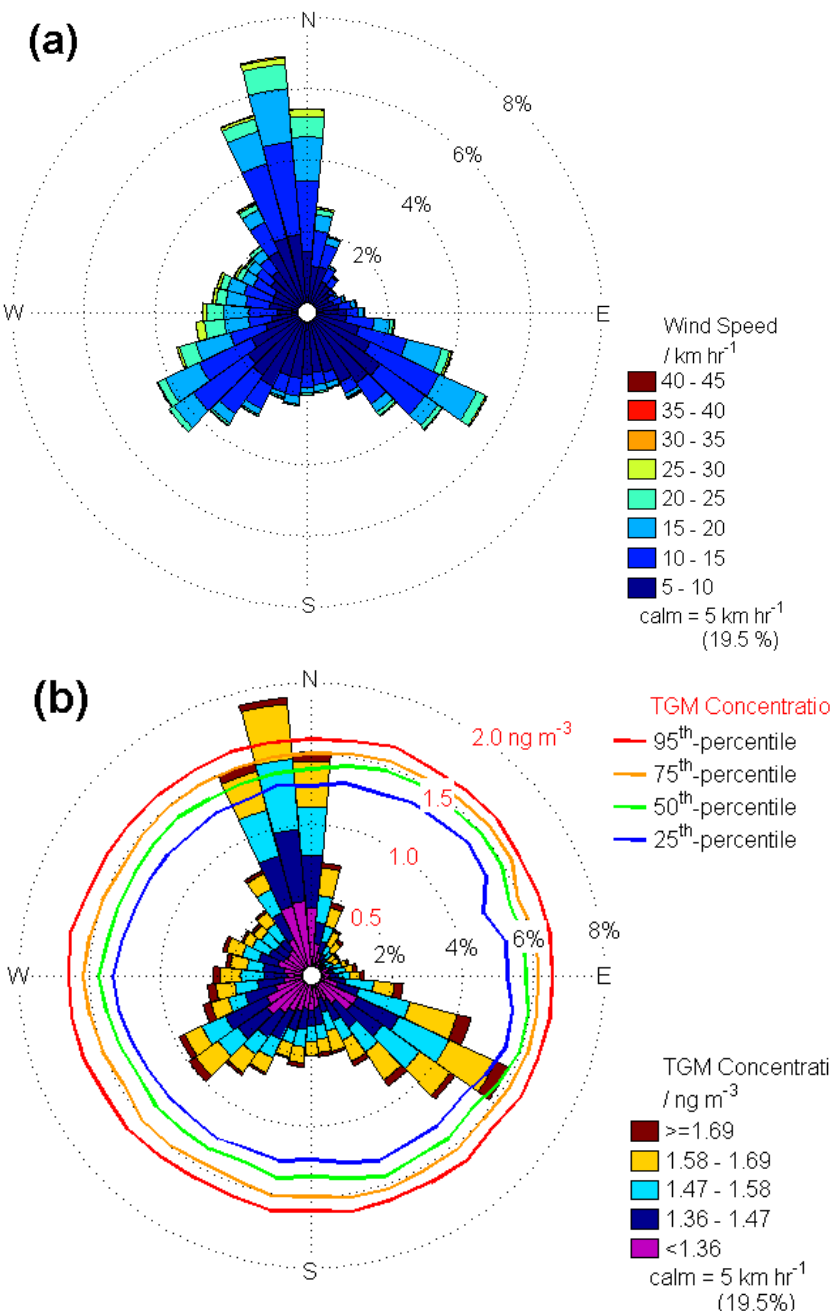
Figure 4. ( a ) Wind rose and ( b ) TGM concentration rose for Patricia McInnes station. Data corresponding to calm winds (wind speed < 5 km·h − 1 ) are not shown here. The TGM rose excludes data impacted by forest fire smoke. Frequency of concentration observations are plotted on the black scale and percentiles in TGM concentrations are plotted on the red radial axis in panel